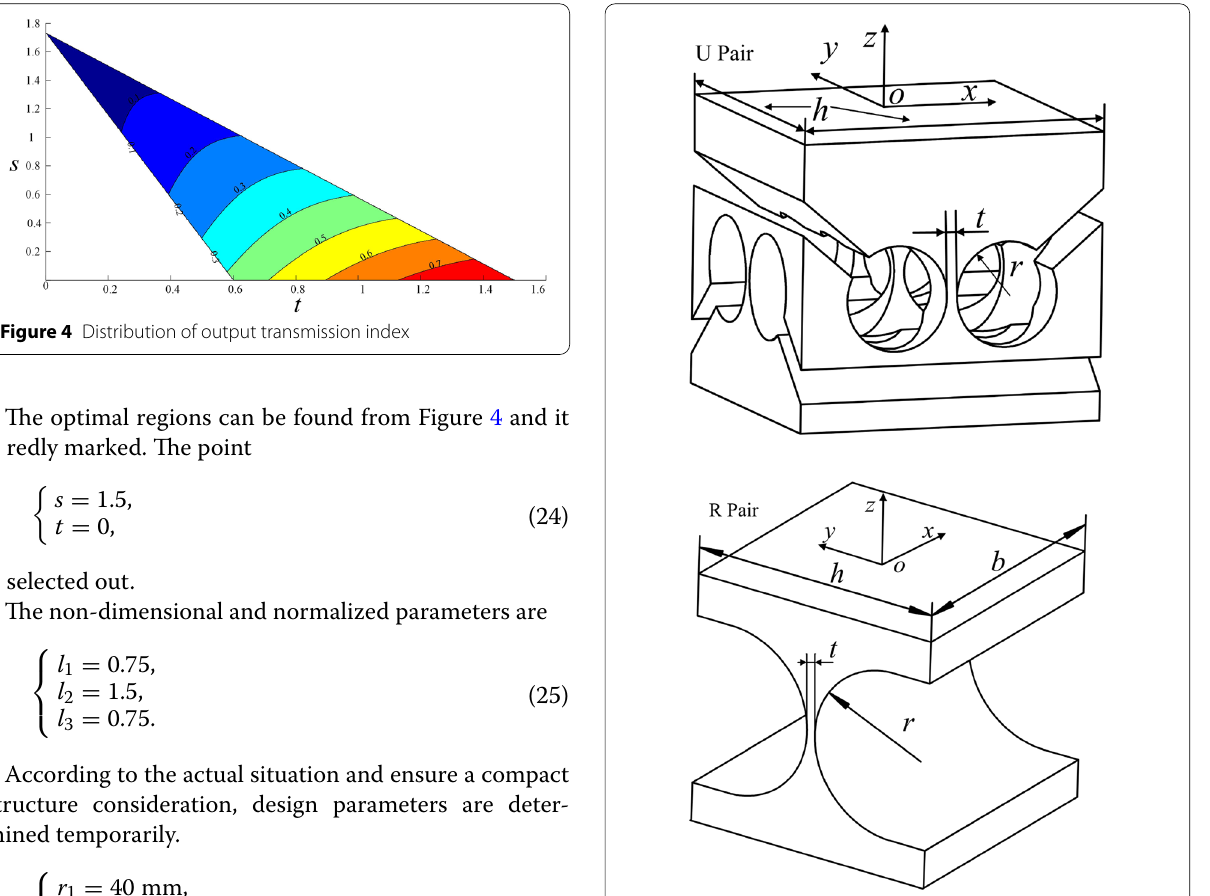
Figure 5 U compliant joint and R compliant